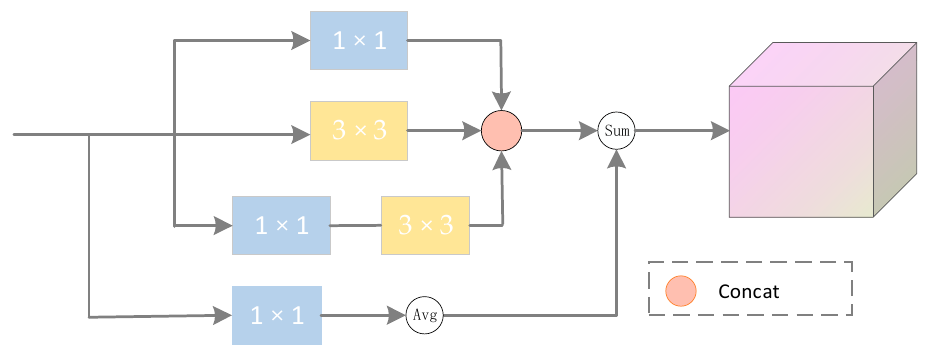
Figure 4. Multiscale augmentation